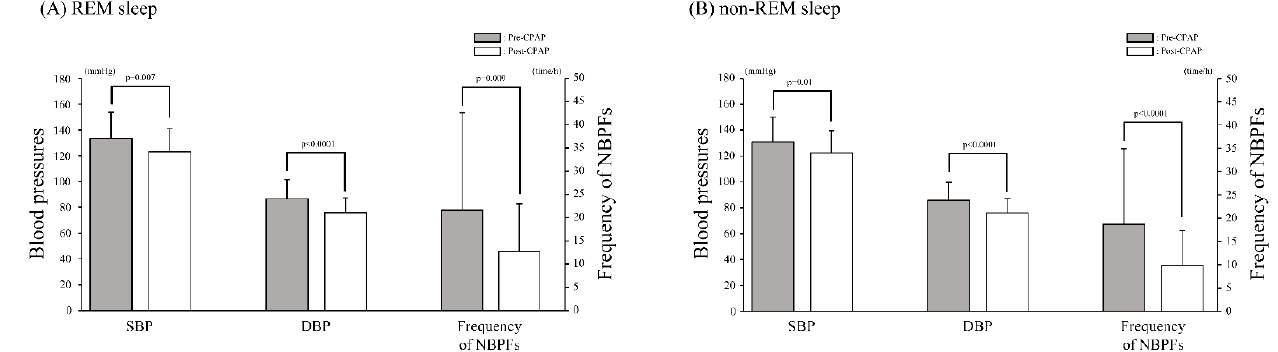
Figure 2. A comparison between blood pressures and NBPFs pre- and post-CPAP. ( A ) REM sleep. ( B ) Non-REM sleep. Gray and white bars indicate the values pre- and post-CPAP, respectively. Values are presented as means ± SDs; error bars represent SD. CPAP, continuous positive airway pressure; DBP, diastolic blood pressure; NBPFs, nocturnal blood pressure fluctuations; SBP, systolic blood pressure; SD, standard deviation.